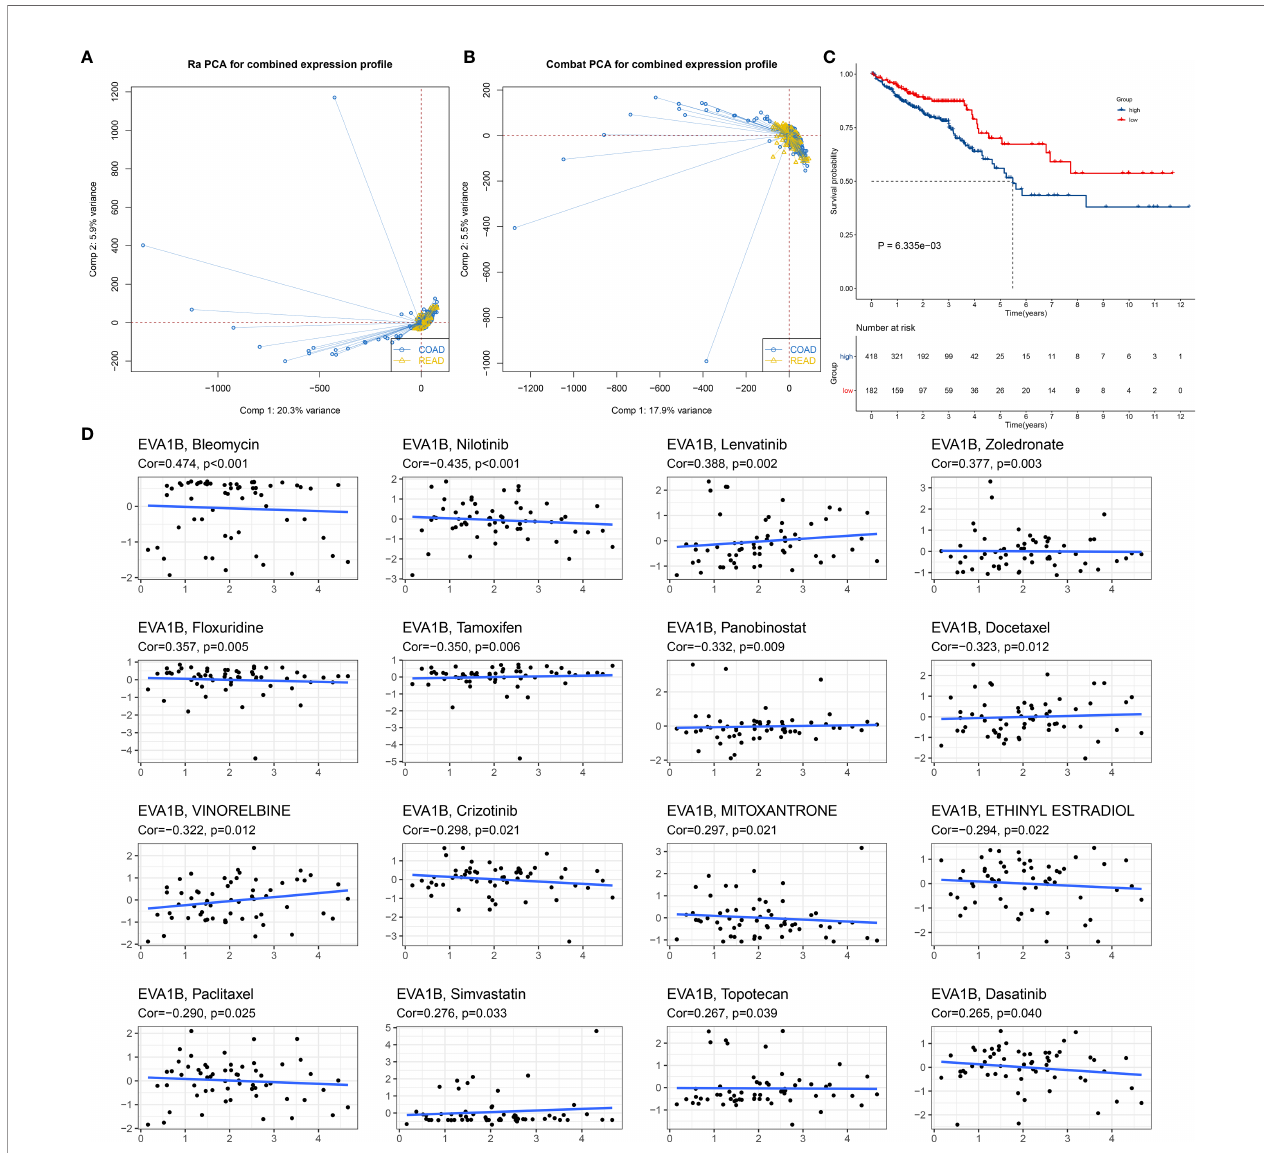
FIGURE 3 | Prognostic signi fi cance of EVA1B and its association with drug sensitivity in CRC. (A, B) PCA diagrams depict the combined COAD and READ datasets from TCGA project before and after removal of batch effects. (C) Kaplan – Meier curves of OS for high and low EVA1B expression subpopulations. (D) Scatter plots show the correlation of EVA1B expression with drug sensitivity in